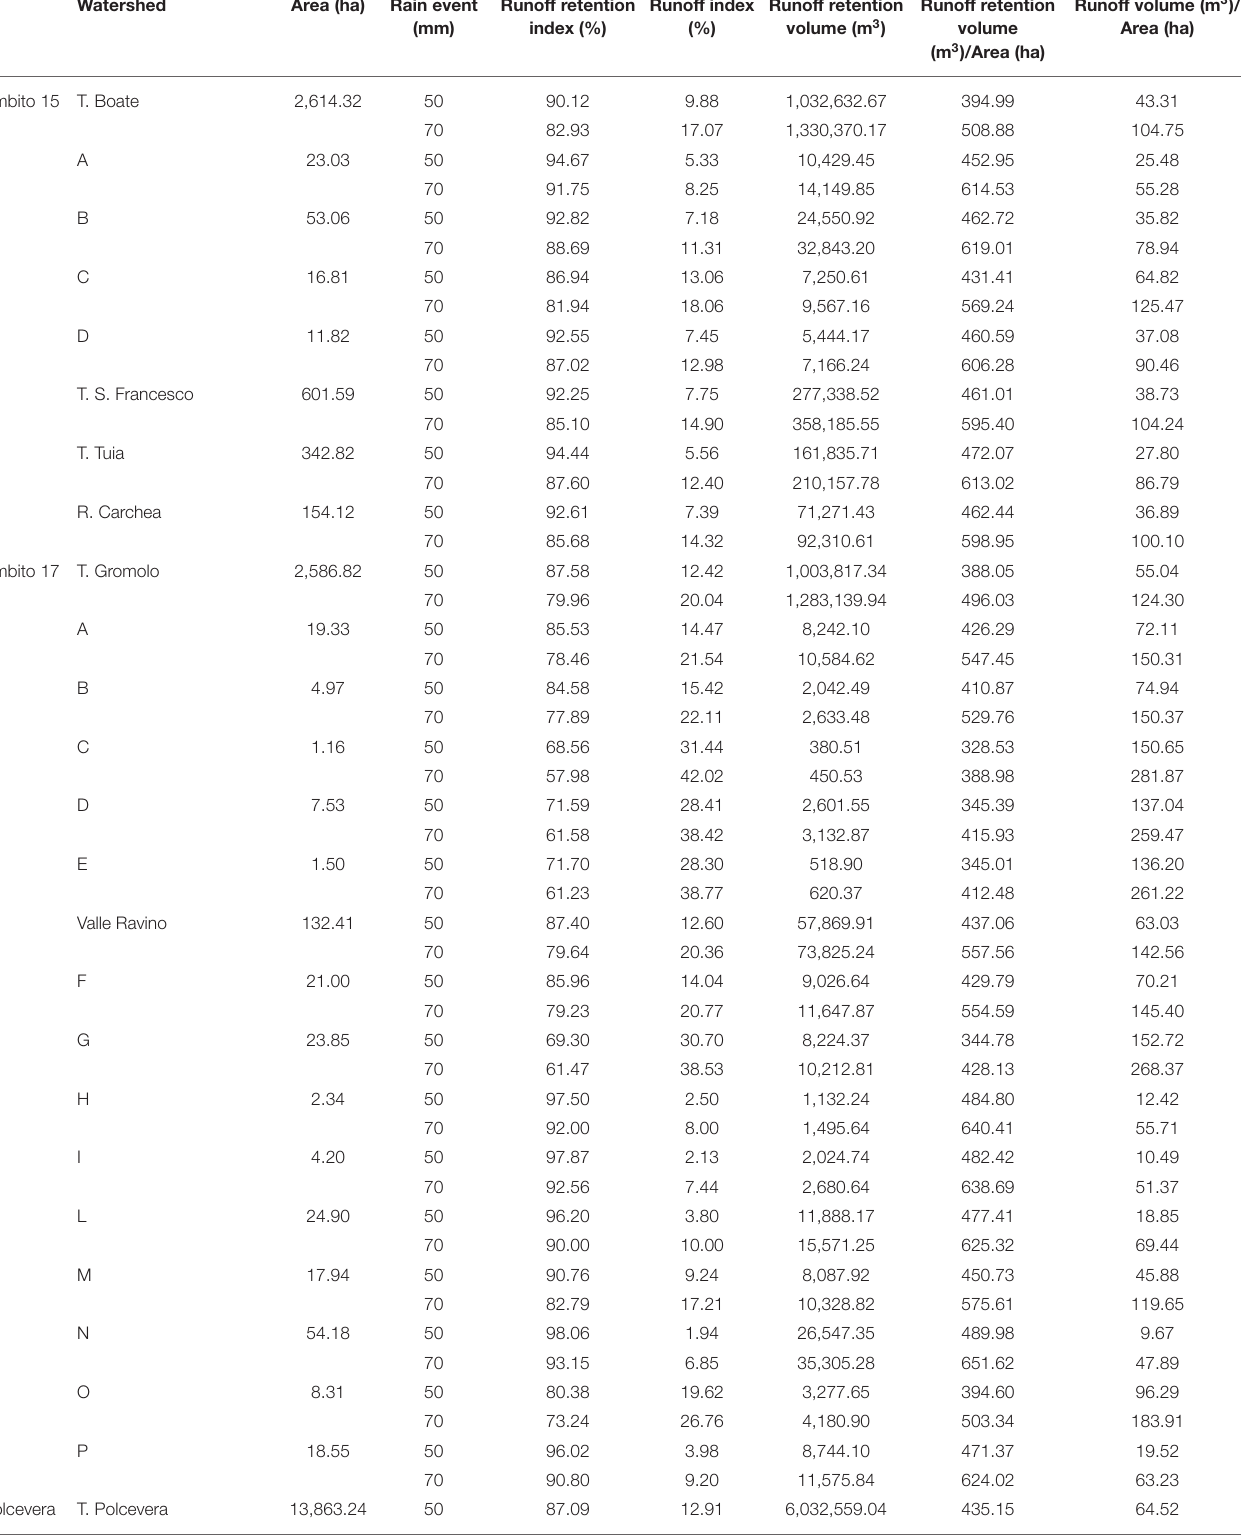
TABLE 4 | Flood Risk Mitigation model output for each of 45 watersheds.